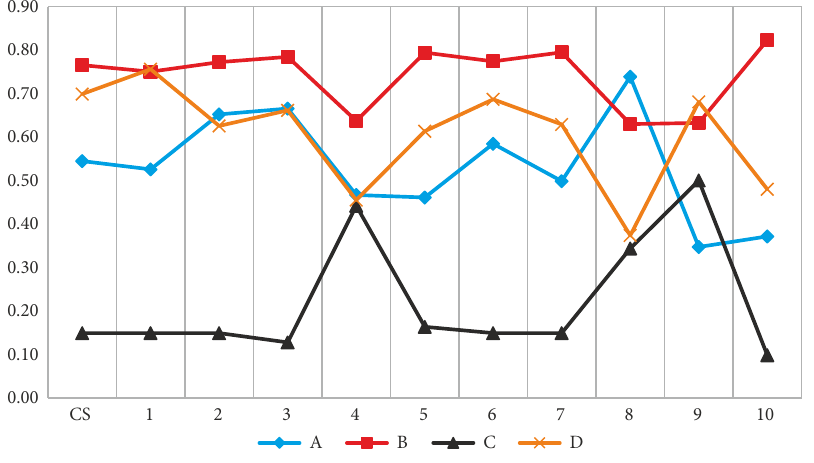
Fig. 3. The sensitivity analysis